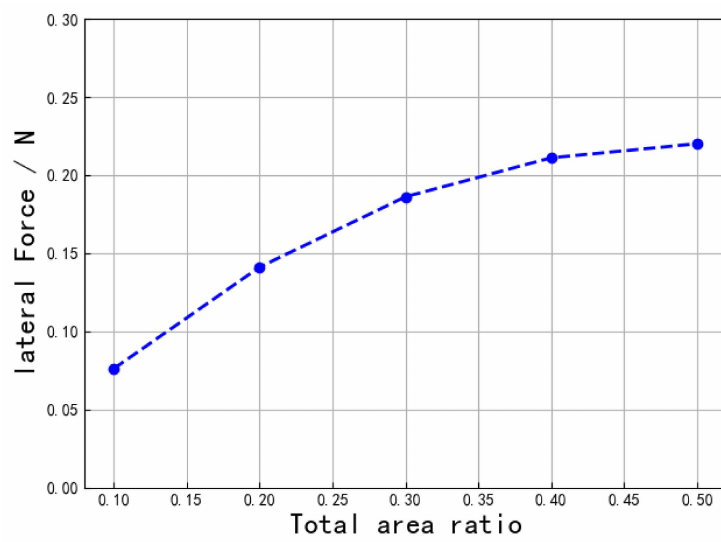
Figure 16. Simulated lateral force–area ratio